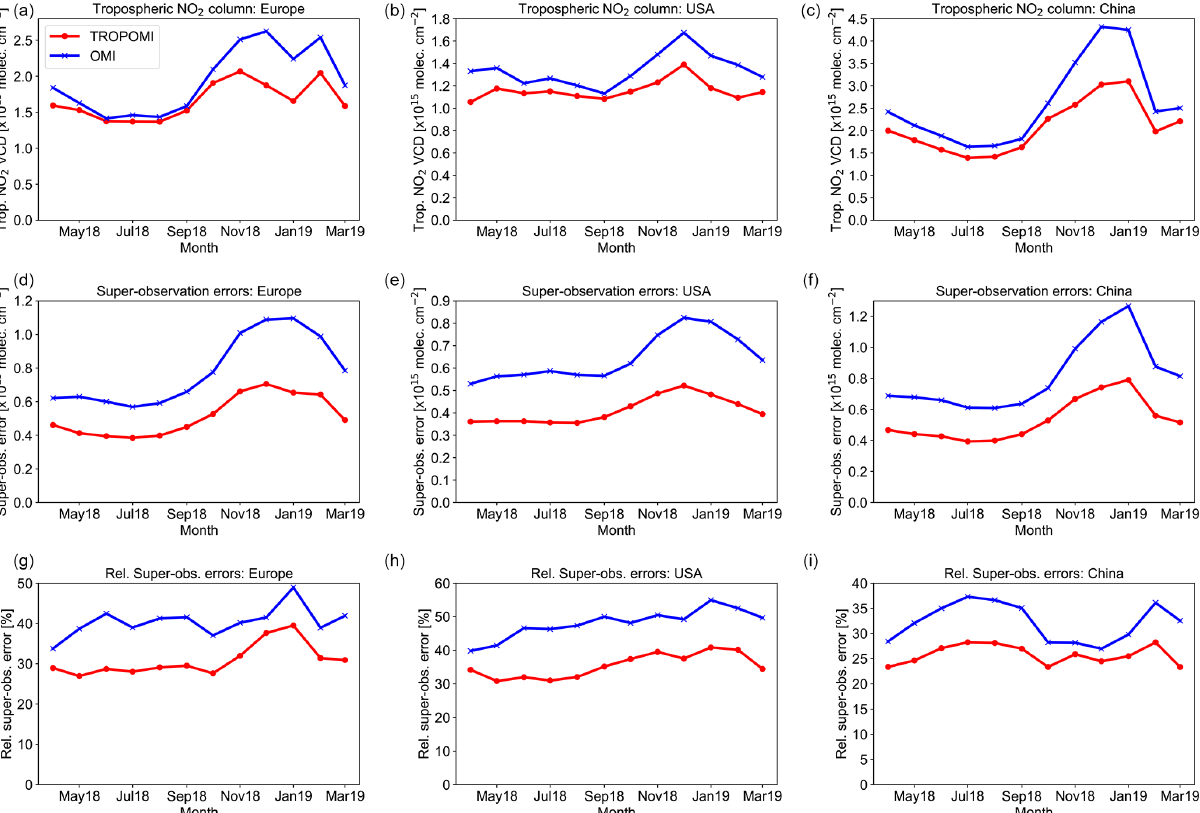
Figure A1. Monthly-mean time series of tropospheric NO 2 column (a, b, c) , super-observation errors (d, e, f) , and relative super-observation errors (g, h, i) obtained from the Tropospheric Monitoring Instrument (TROPOMI) version 1.2 beta (April–May 2018) and version 1.2 (June 2018–March 2019) products during April 2018–March 2019 over Europe ( a, d, g ; 35–60 ◦ N, 10 ◦ W–30 ◦ E), the United States ( b, e, h ; 28– 50 ◦ N, 70–125 ◦ W), and China ( c, f, i ; 18–50 ◦ N, 102–132 ◦ E). The units of the tropospheric NO 2 column, super-observation errors, and relative super-observation errors are × 10 15 molec.cm − 2 , × 10 15 molec.cm − 2 , and percentage (%),